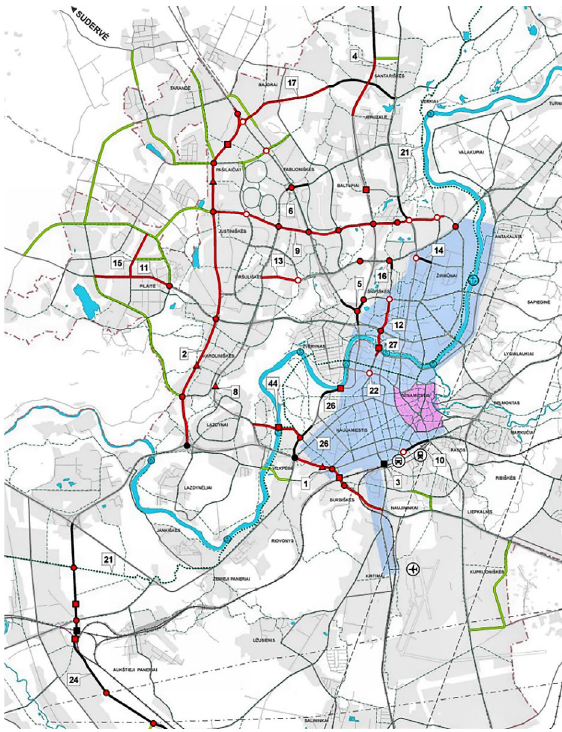
Fig. 3. Transport network development in Vilnius City until 2025 (based on the Master Plan of the City of Vilnius)